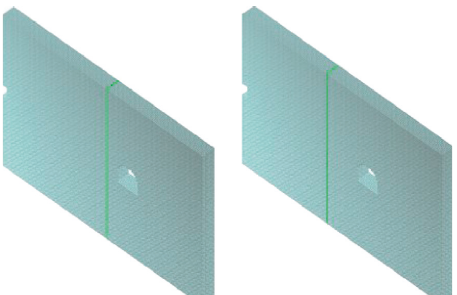
Figure 8: Schematic diagram of the model when the distance between the discontinuity and the adjacent tunnel is 4m and 12m, respectively.